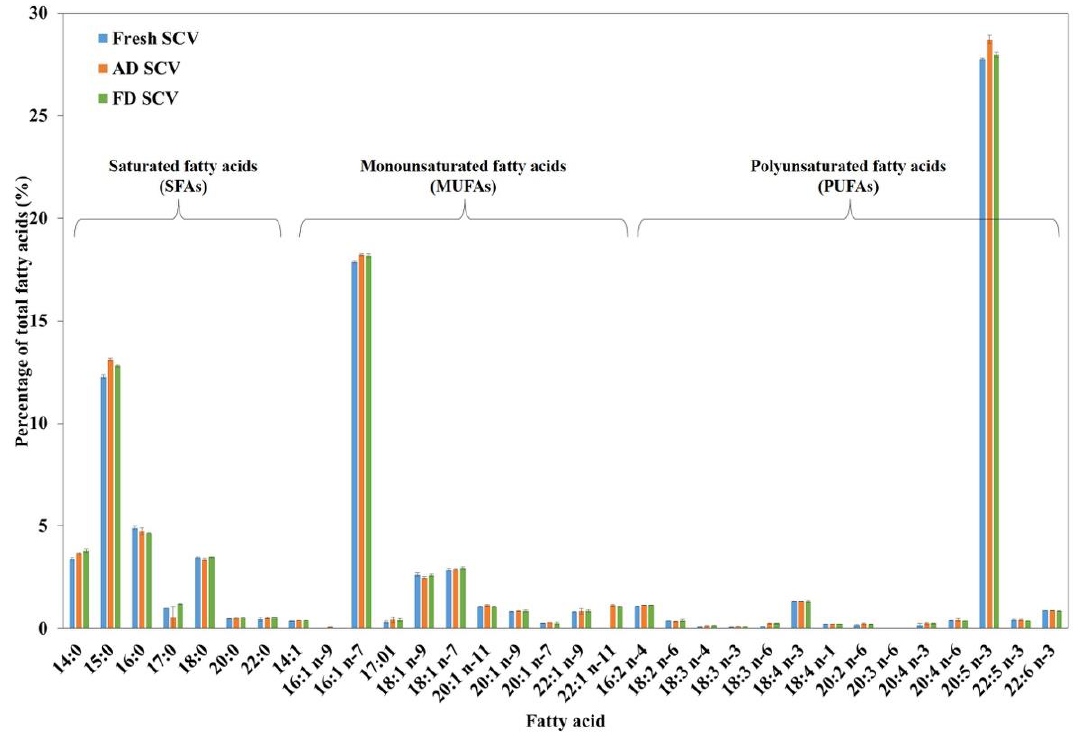
Figure 6. Total fatty acid composition of fresh, air-dried (AD SCV), and freeze-dried (FD SCV) sea cucumber viscera.